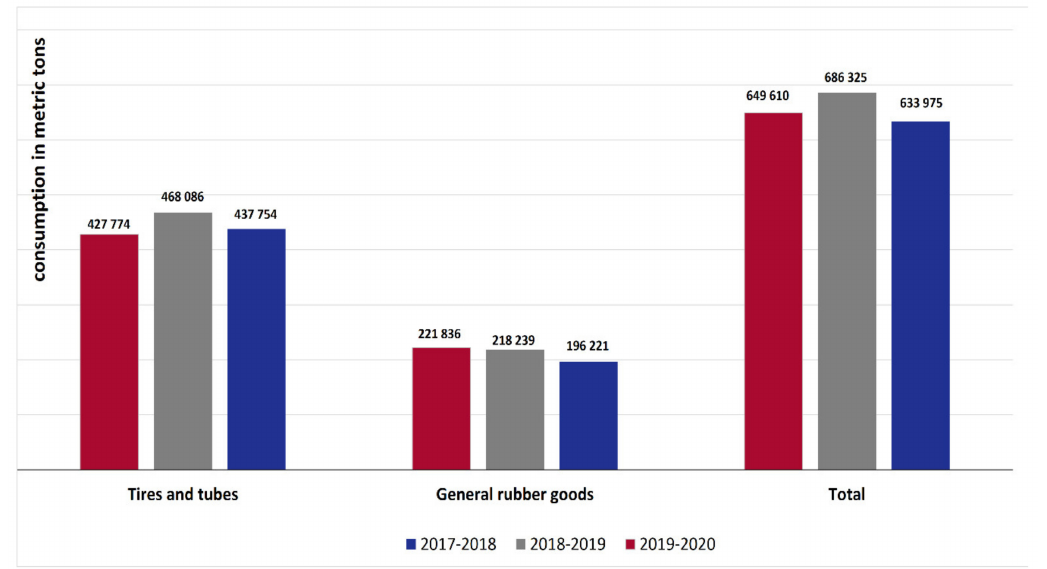
Figure 3. Consumption of synthetic rubber. Source: statista.com, 27 May